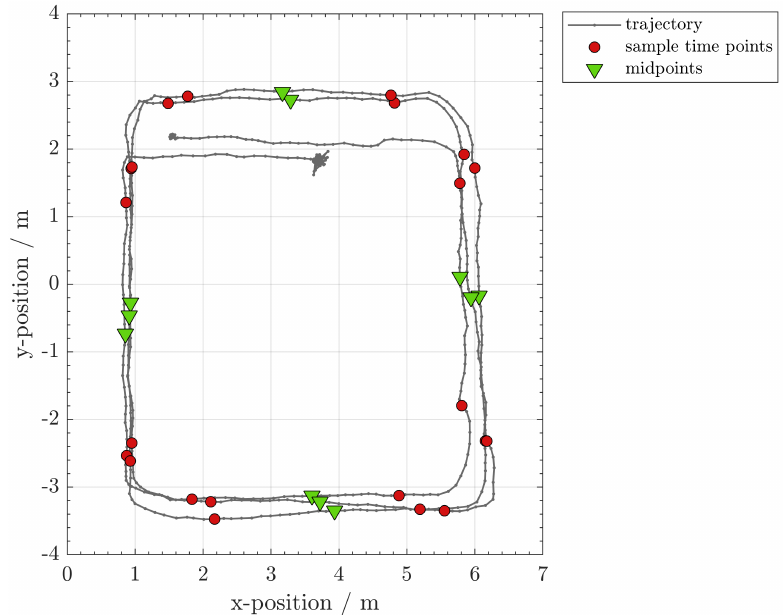
Figure 8. Using the inertial measurement unit, one can detect the straight lines. The shown trajectory is estimated using ultrasound localization and known anchor positions. While this is not the case, it shows how the target moved during the calibration phase. The magenta points are critical points which define the starting and ending points of the straight